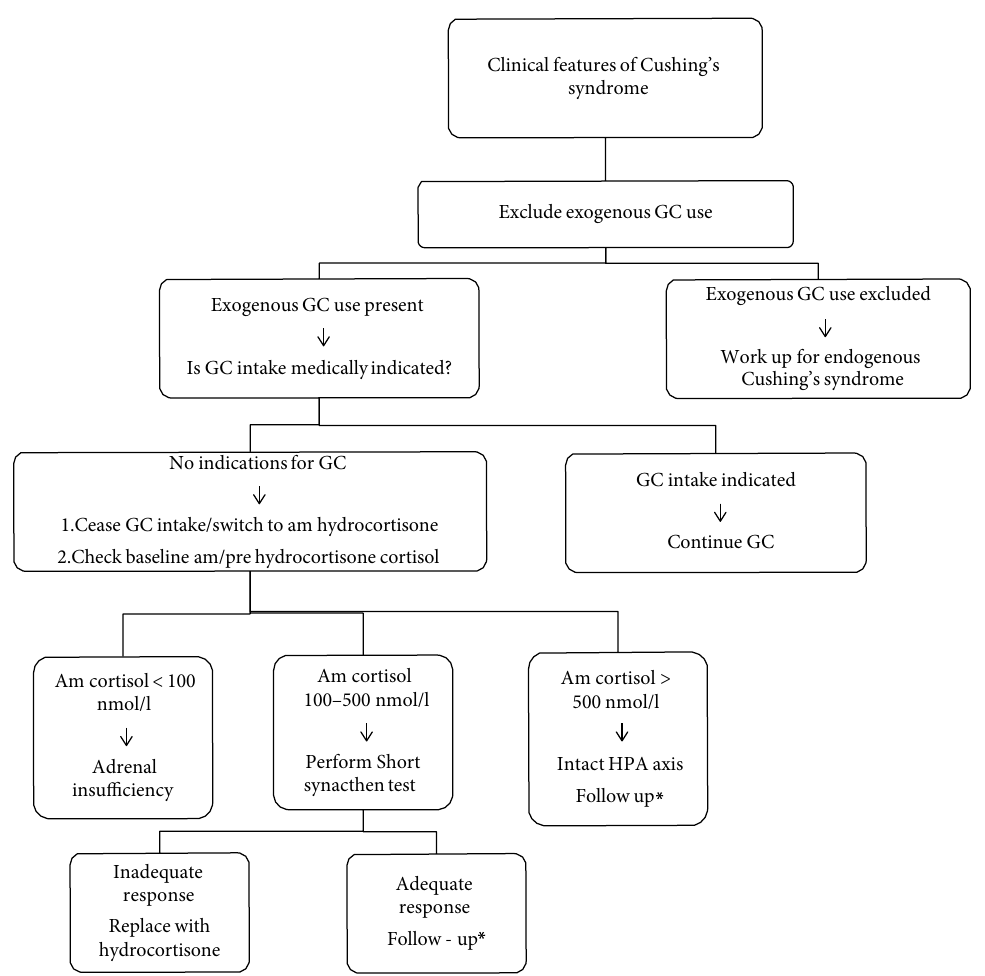
Figure 2: Algorithm for workup of a patient with exogenous Cushing’s syndrome. ∗ Glucocorticoids tapered and off. Patients are followed up and assessed for resolution of Cushingnoid features. If features persist, to consider concurrent endogenous Cushing’s